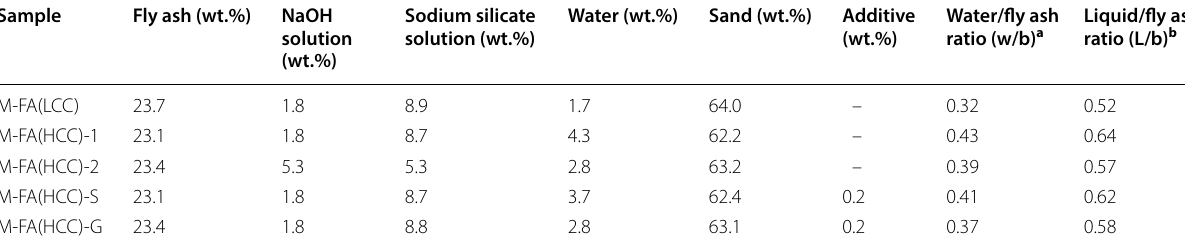
a Water/fly ash ratio b Liquid/fly ash ratio